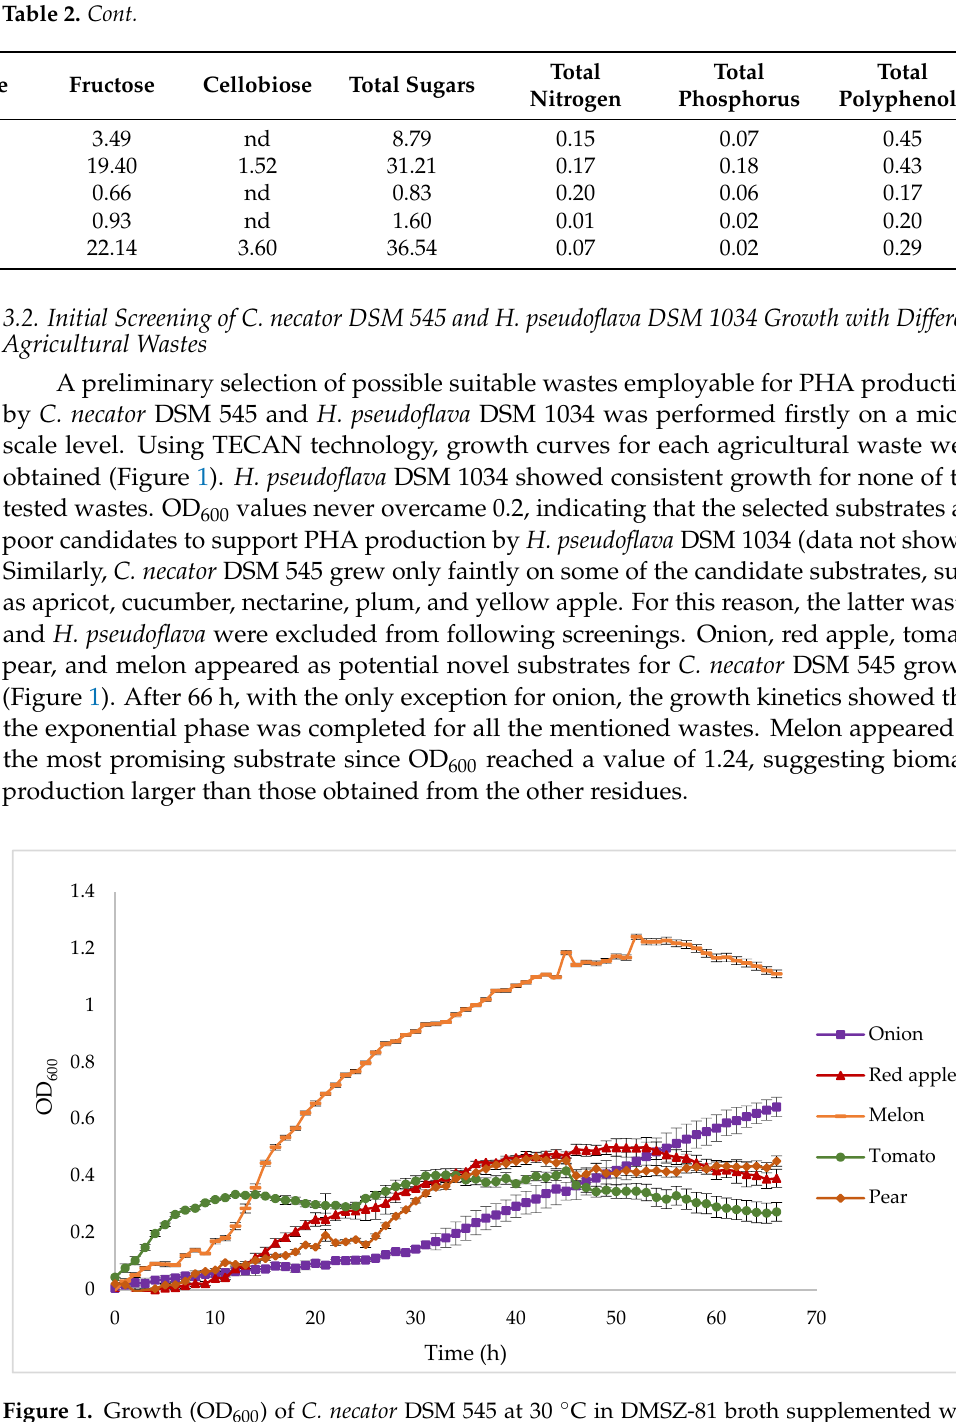
Table 2. Composition (g/L) of extracted solutions for the agricultural wastes considered in this work. Wastes labeled by * originated from industrial processes. nd: not detected.